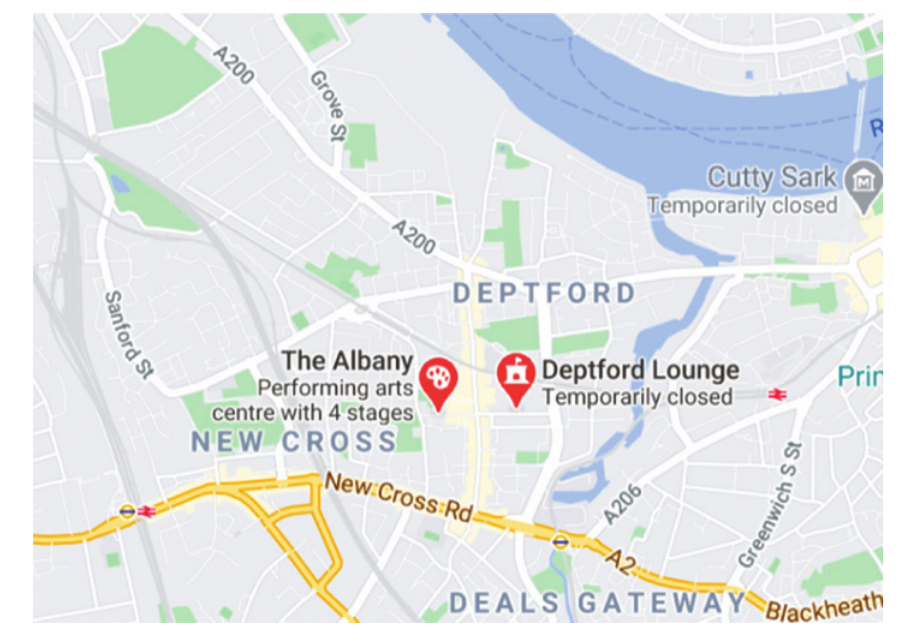
figure 4: Markers showing the locations of The albany and the Deptford lounge (illustration derived from Google